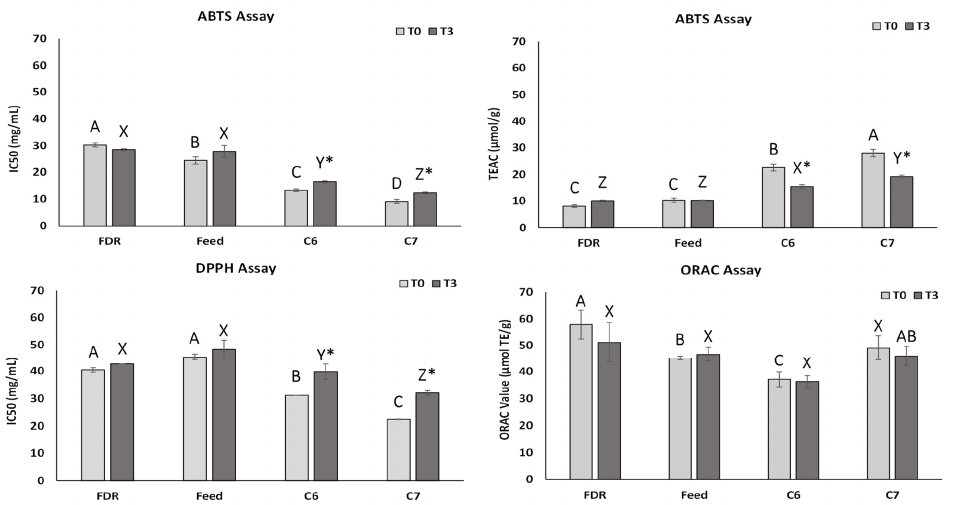
Figure 3. Antioxidant values determined by ABTS, DPPH, and ORAC assays for the FDR, Feed, C6, and C7 samples over the accelerated stability storage (T0 vs. T3). A,B,C letters on top of bars for significant differences ( p < 0.05) among samples at T0. X,Y,Z for significant differences ( p < 0.05) at T3. * significant differences ( p < 0.05) along time for a same sample (i.e., T0 vs. T3).